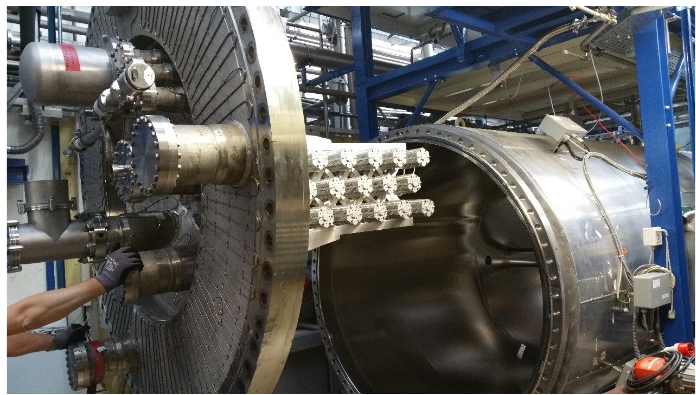
Figure 9. TIMO during installation of the developed NEG